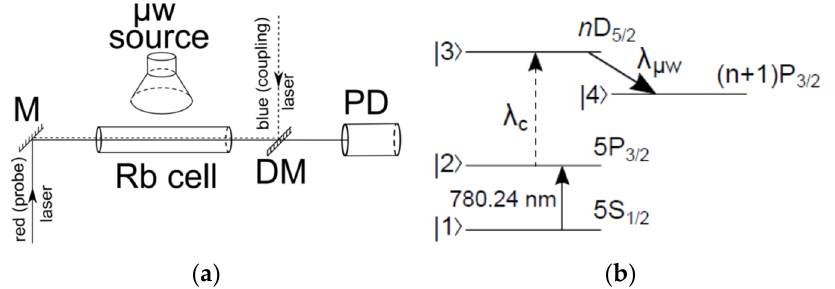
Figure 1. (From Ref. [13]). ( a ) Scheme of the experimental setup (M—mirror, DM—dichroic mirror, PD—photodetector); ( b ) energy level scheme used for the observation of the EIT resonance splitting in Rb atoms. The coupling laser wavelength λ c changes in the region between 479 and 484 nm, and λ µ w changes between 100 µ m and 10 cm, depending on the Rydberg-state principal quantum number n in the region between 20 and 100.